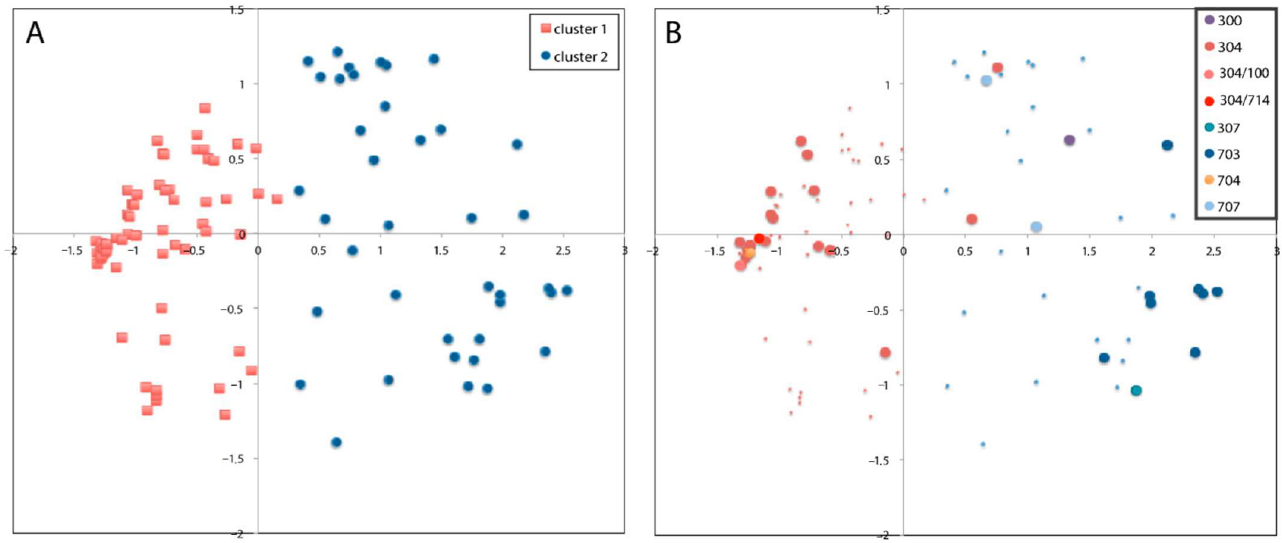
Figure 3. Plot of the principal coordinate analysis (PCO). ( A ) PCO of 109 unique genotypes shown on the first and second axis, with the proportion of ancestry from each cluster for each sample indicated by color: red shading is Cluster 1 and blue shading is Cluster 2; ( B ) distribution of the eight races of P. halstedii (100, 300, 304, 307, 703, 704, 707, and 714) within the field at the 20 sites (the figure shows the coexistence of more than one race at a site).